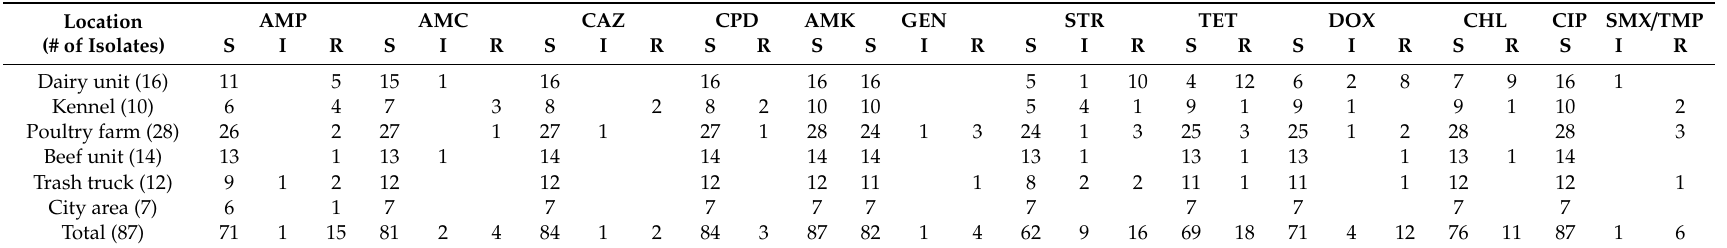
Table 2. Antibiotic susceptibility profile of E. coli isolated from flies.